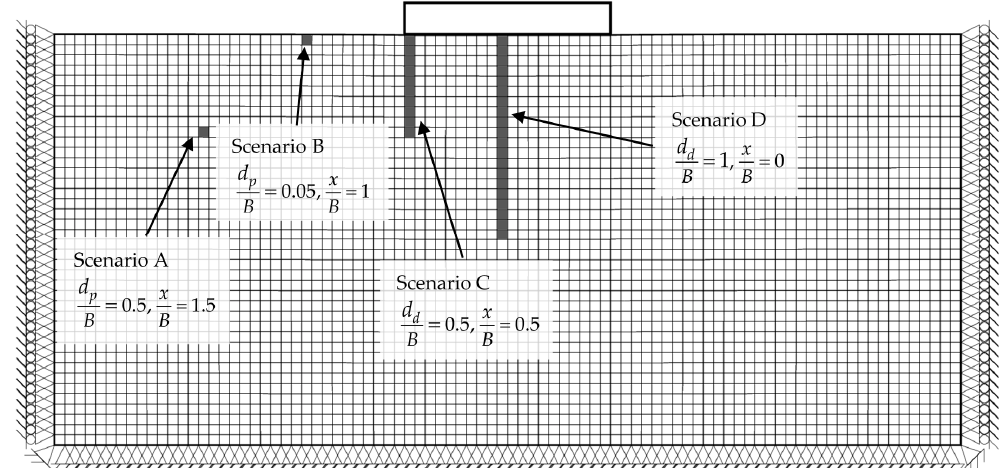
Figure 2. Graphical representation of single sampling point ( d p ; Scenario A and B ) and sampling domain length ( d d ; Scenario C and D ) sampling strategies.